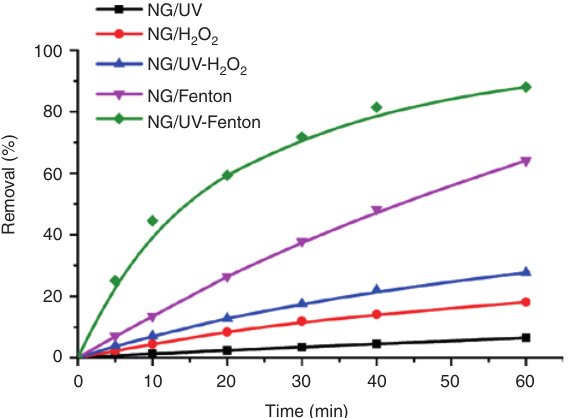
Figure 1: Efficiency of NG removal vs. time in different advanced oxidation systems.